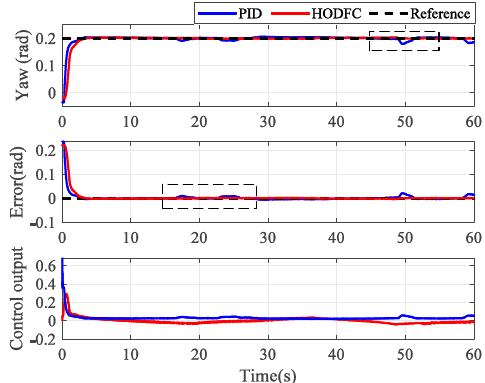
Figure 9. Experimental results with a fixed yaw angle of 0.2 rad. Table 3. Numerical performance metrics of the static trajectory.